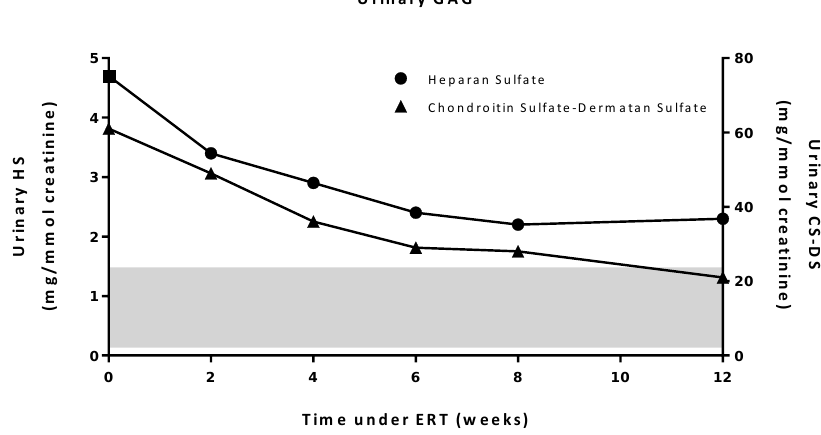
Figure 4. Levels of urinary heparan sulfate and chondroitin sulfate-dermatan sulfate under ERT. The value at time 0 corresponds to baseline levels prior to ERT. The shaded band corresponds to the range of control values.